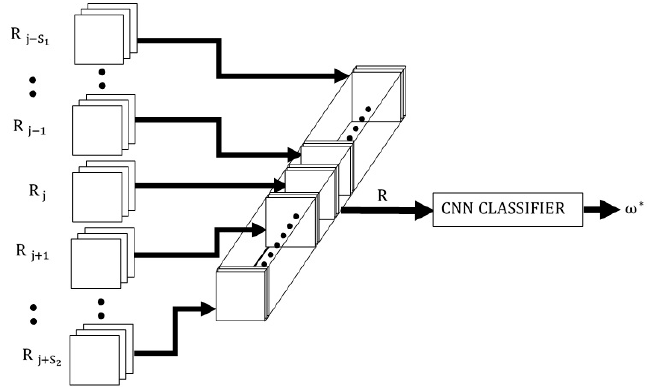
Figure 3. The multidimensional CINET(S) classifier model.